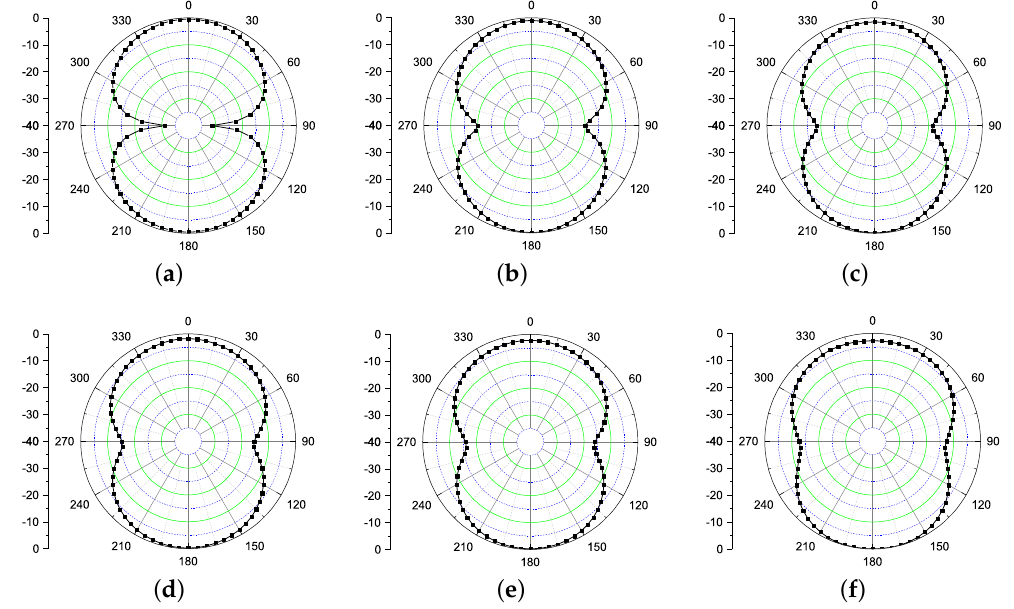
Figure 3. Simulated radiation patterns of Iteration 1 design (xz plane) at ( a ) 868 MHz ( b ) 3 GHz ( c ) 3.5 GHz ( d ) 4 GHz ( e ) 4.5 GHz ( f ) 5